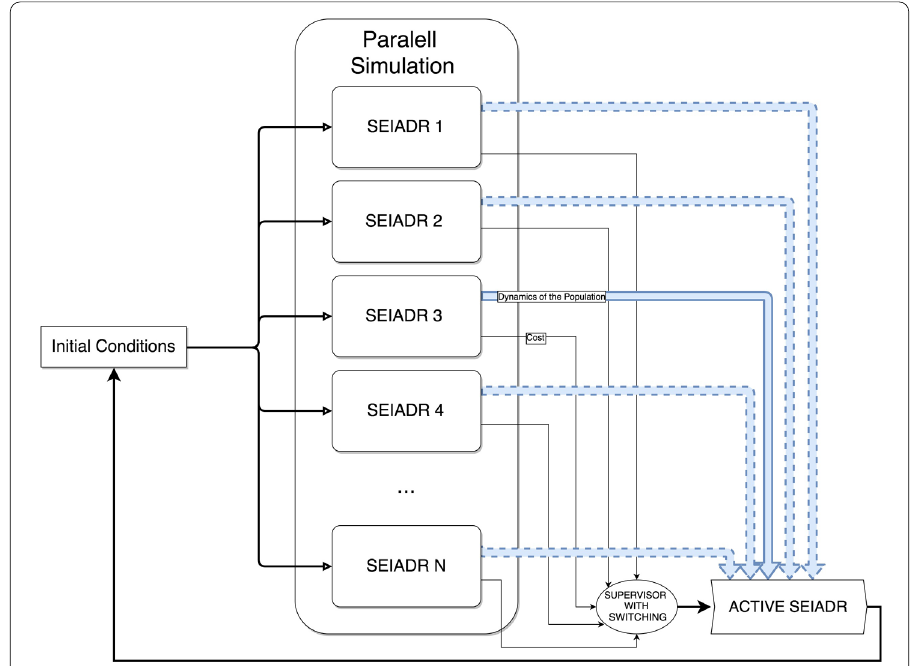
Figure 2 Parallel multicontrol